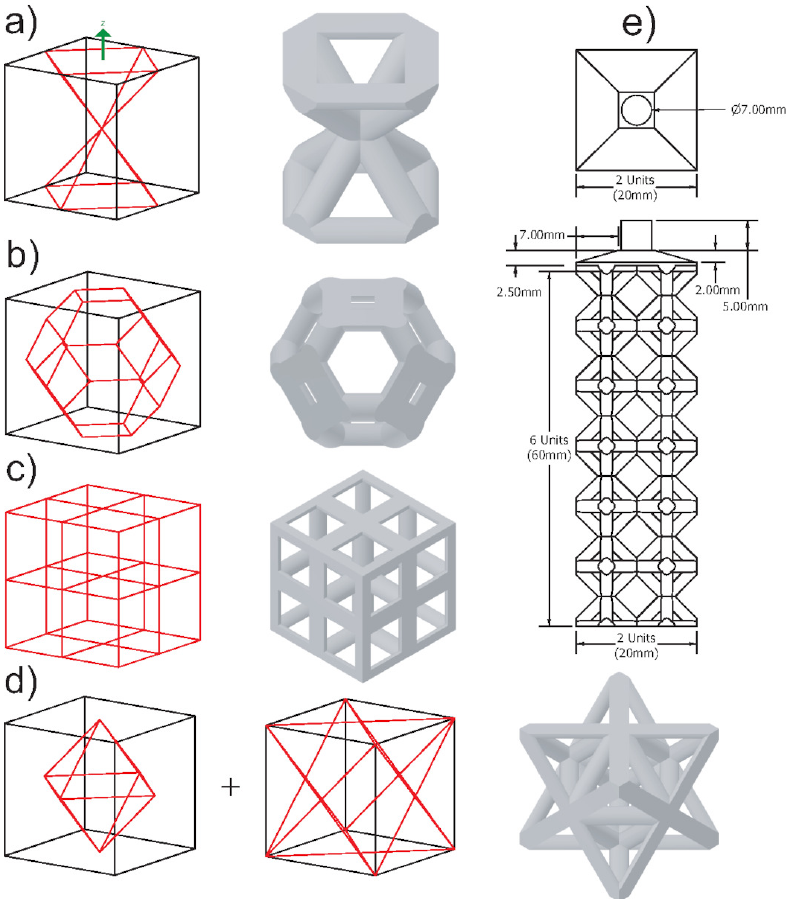
Figure 3. Test 1 lattice cells and structure: ( a ) Rhombic. ( b ) Kelvin Cell. ( c ) Cubic. ( d ) Octet-Truss. ( e ) 2 × 2 × 6